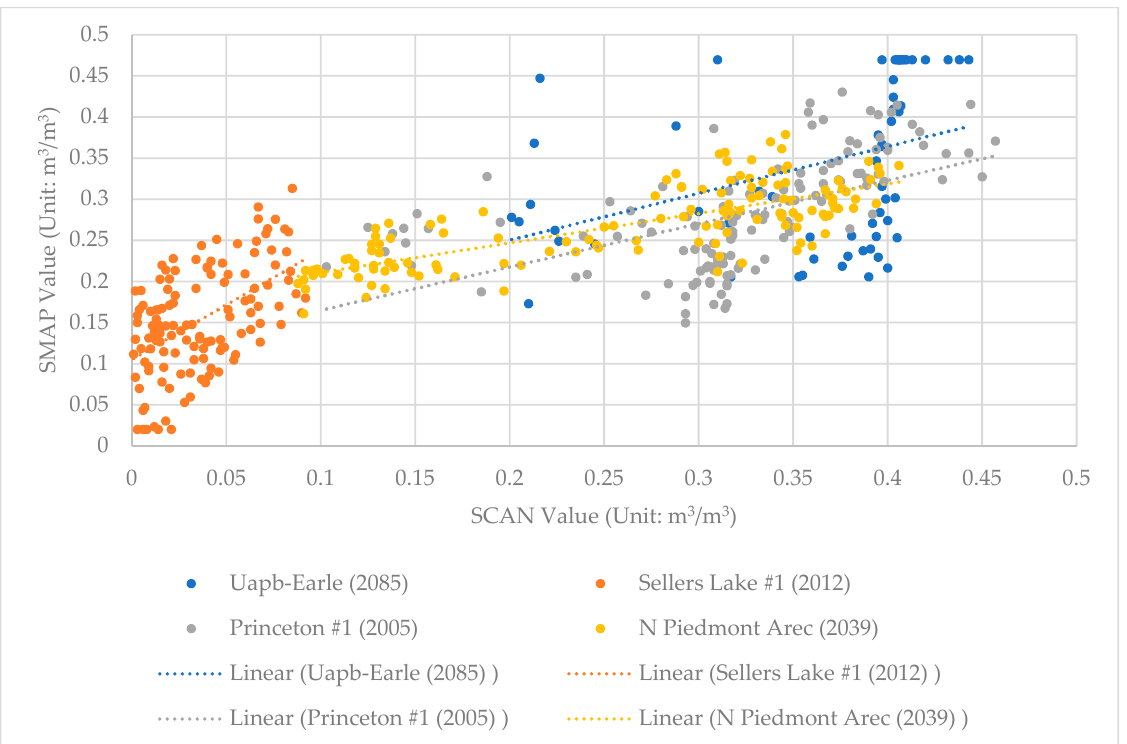
Figure 4. Scatter plot between SCAN values and SMAP values for the four anomaly stations with the R-squared values: Uapb-Earle station in Arkansas (for the year 2015), R-squared value was 0.1506; N Piedmont Arec station in Virginia (for 2016), R-square value was 0.2499; the Sellers Lake #1 station in Florida (for 2015), R-square value was 0.2827; and the Princeton #1 station in Kentucky (for 2015), R-square value was 0.3115.